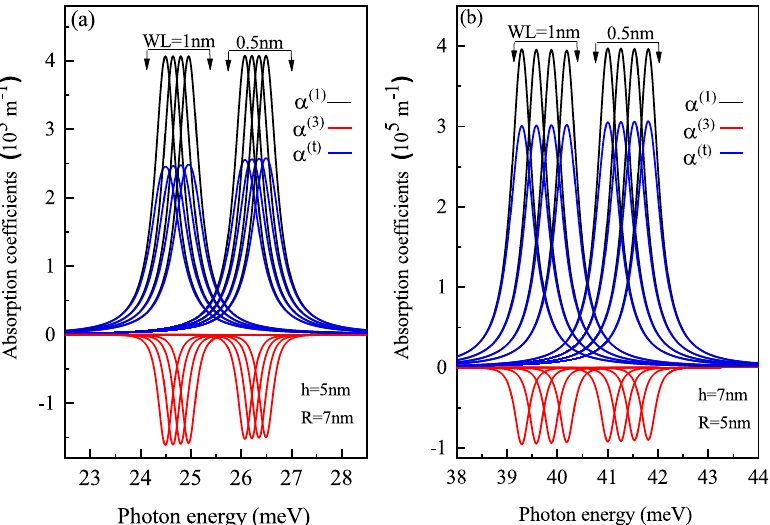
Figure 15. Linear, non-linear and total absorption coefficients as a function of the photon energy for ( a ) oblate height h = 5 nm with radius R = 7 nm at WL thickness 0.5 nm and 1 nm ( b ) prolate QD with R = 5 nm, h = 7 nm with WL = 0.5 nm and 1 nm, at four perpendicular electric field strengths of F = 0, 5, 10 and 15 kV/cm from left to right respectively.